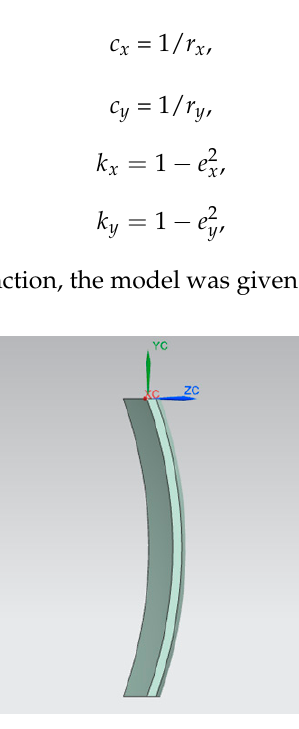
Figure 1. Thin-walled double side aspheric component model.